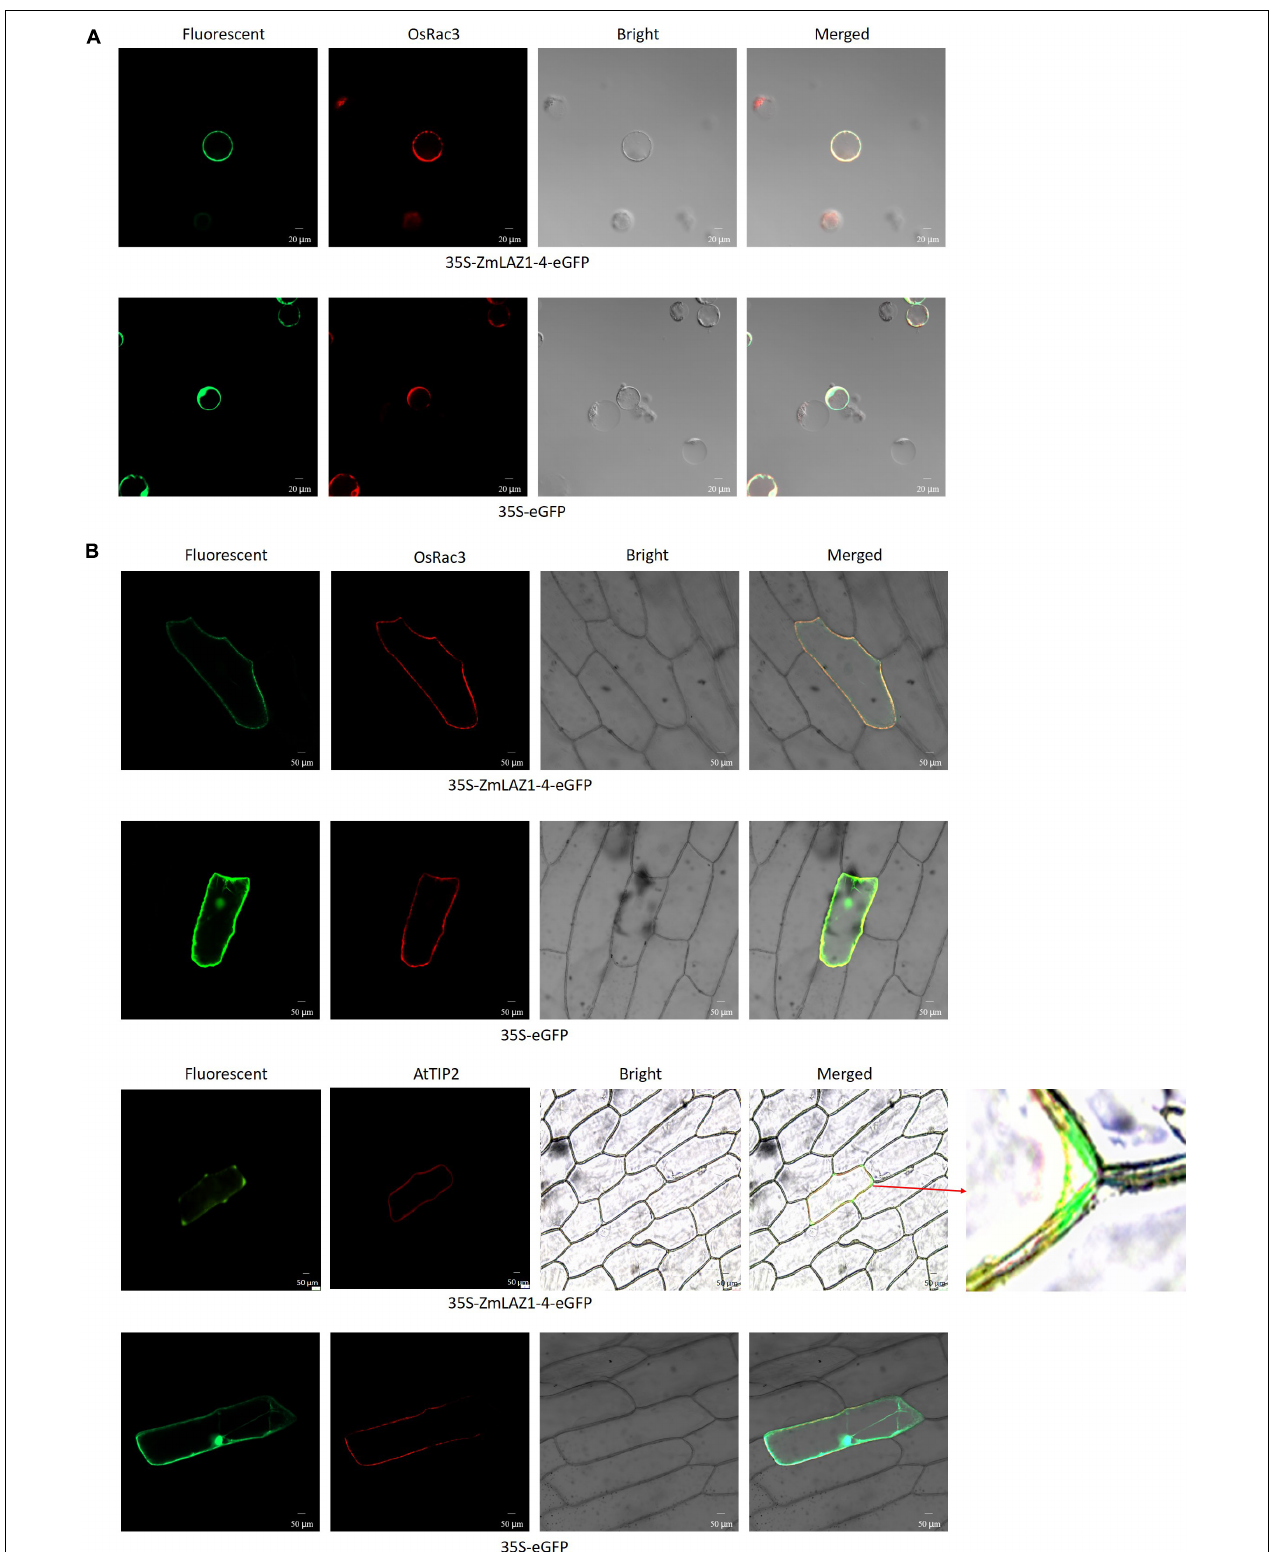
FIGURE 5 | Subcellular localization of ZmLAZ1-4 in maize protoplasts (A) and onion cells (B) . Scale bar is 50 µ m.